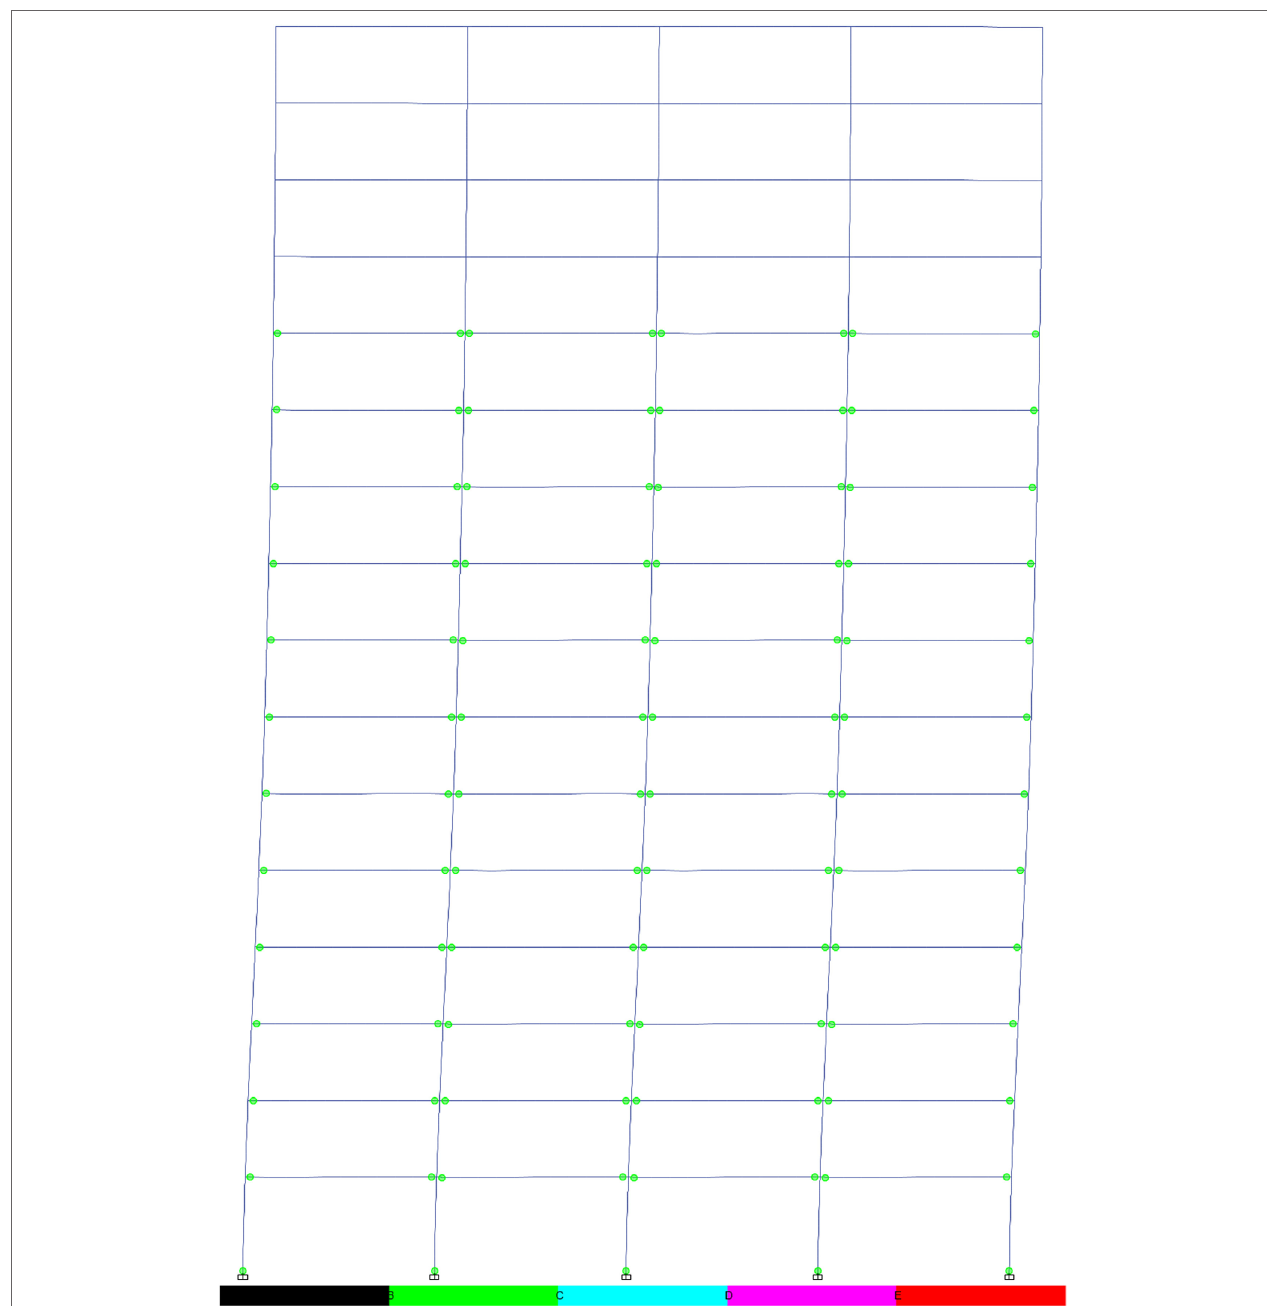
Figure 27 | Plastic hinge formation in 16-storey frame with reduced web sections (for cross sections, see Figure 5 and Table 4